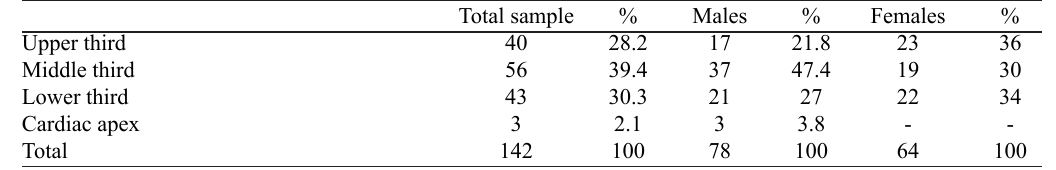
Table 3. Finish of anterosuperior branch (ASB) of anterior interventricular artery (AIA) on the obtuse side of the heart, by gender